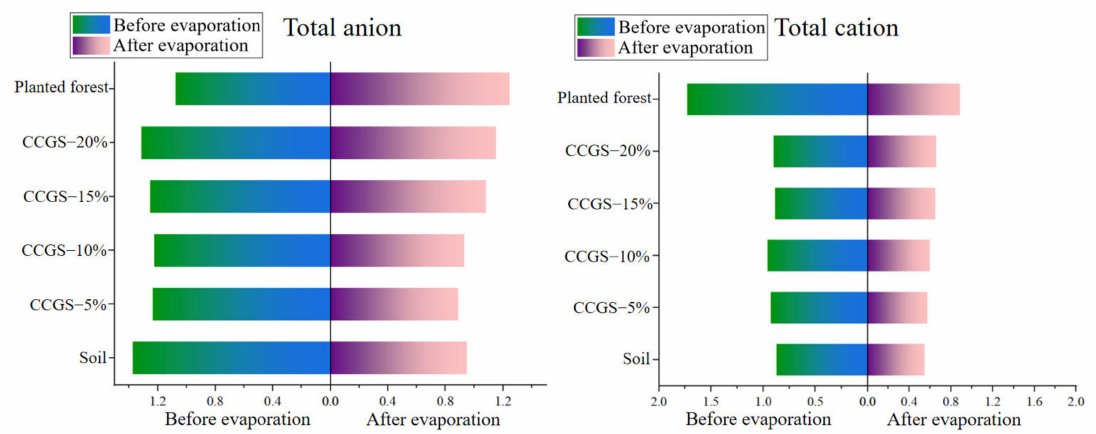
Figure 21. Changes of anion and